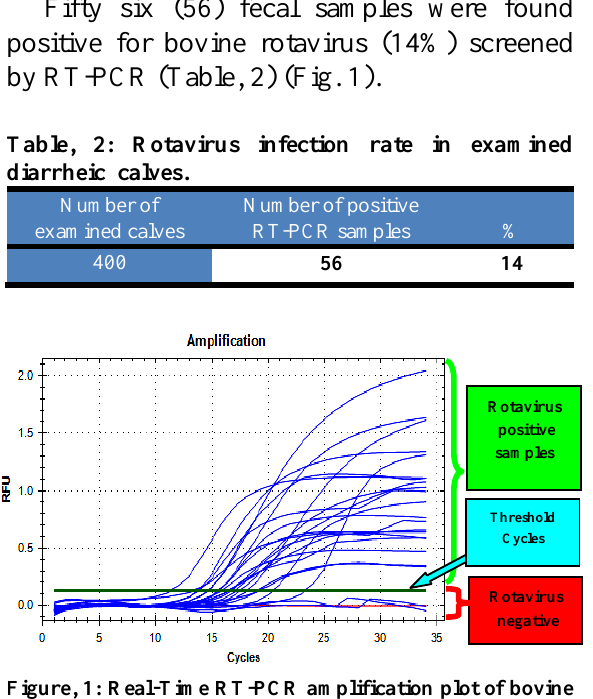
Figure, 1: Real-Time RT-PCR amplification plot of bovine rotavirus.